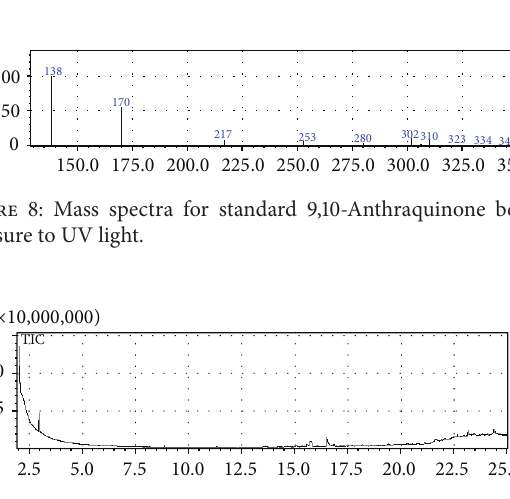
Figure 9: Chromatogram of GC-MS for standard 9,10-Anthra- quinone after exposure to UV light.